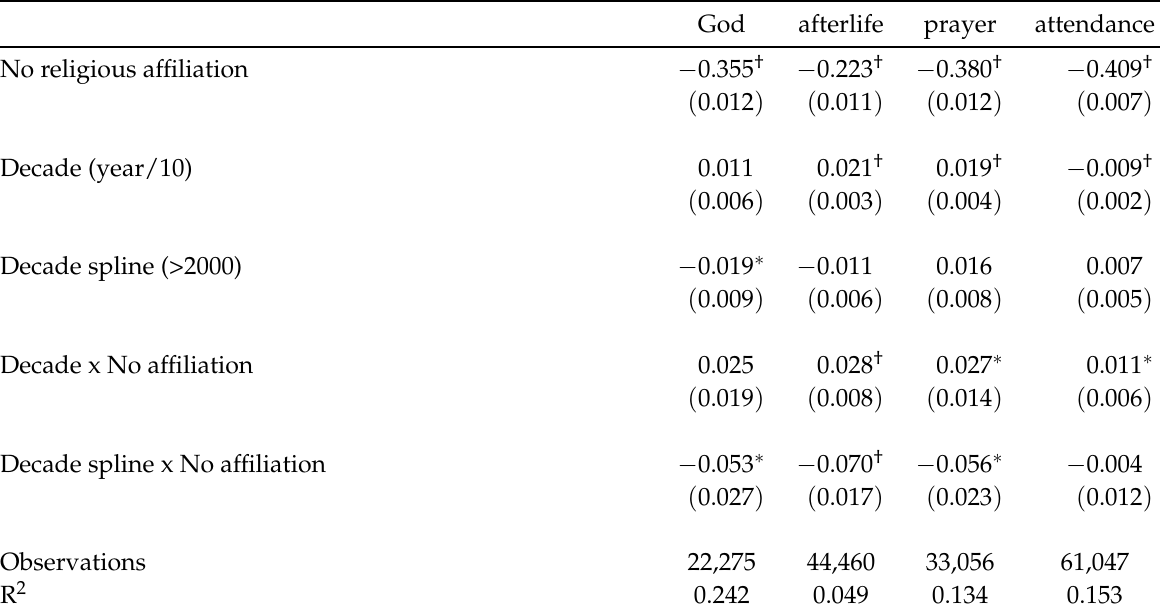
Table 2: Linear regression models predicting strength of belief in God, belief in the afterlife, frequency of prayer, and freqency of attendance at religious services based on General Social Survey